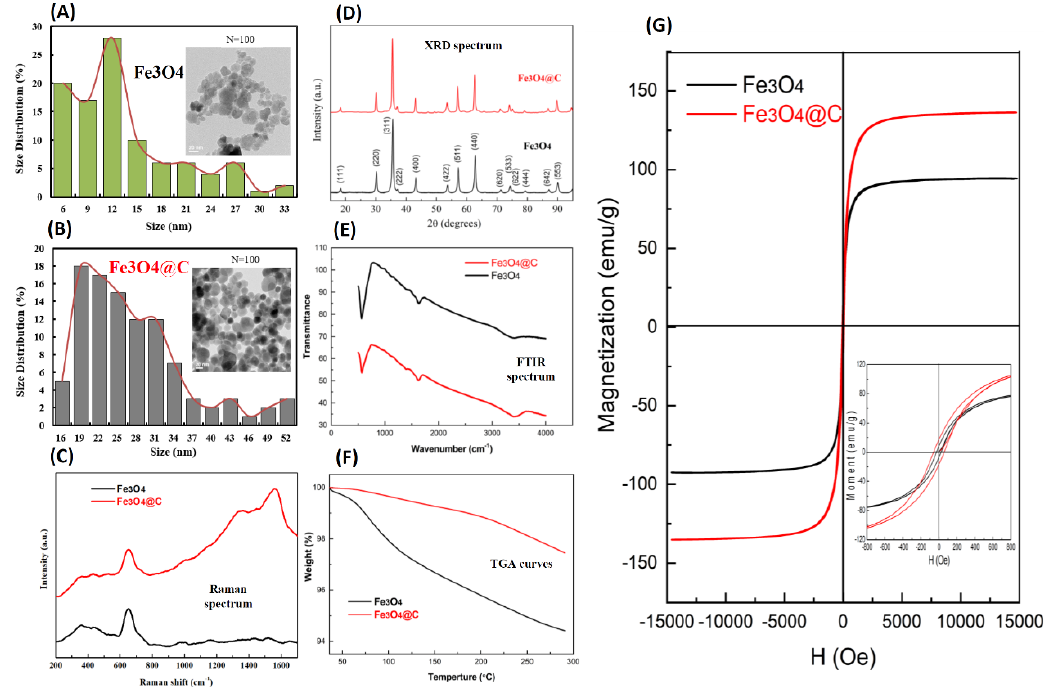
Figure 1. Transmission electron microscope images and size distribution of ( A ) pristine Fe 3 O 4 magnetic nanoparticles (Fe 3 O 4 ),and ( B ) carbon-coated Fe 3 O 4 MNPs (Fe 3 O 4 @ C) . ( C ) Comparison of Raman spectrum between pristine Fe 3 O 4 magnetic nanoparticles (MNPs) (black color) and carbon-coated Fe 3 O 4 MNPs (red color). ( D ) Comparison of the XRD (X-ray Diffraction) spectrum between pristine Fe 3 O 4 MNPs (black color) and carbon-coated Fe 3 O 4 MNPs (red color). ( E ) Fourier-transform infrared spectroscopy (FTIR) spectra of pristine Fe 3 O 4 and carbon-coated Fe 3 O 4 NPs. ( F ) TGA (Thermogravimetric analysis) curves of pristine Fe 3 O 4 and carbon-coated Fe 3 O 4 NPs. ( G ) Magnetization versus applied field for pristine Fe 3 O 4 and carbon-coated Fe 3 O 4 NPs. The insert shows hysteresis loops.